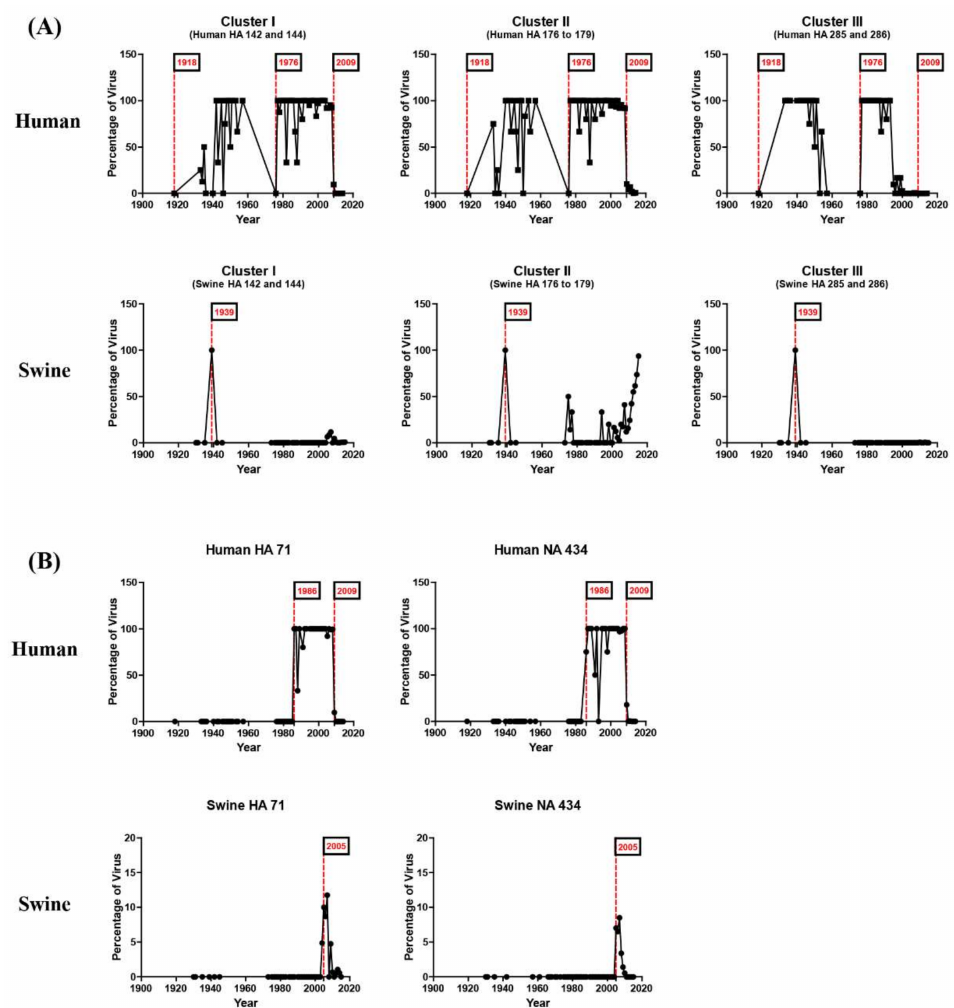
Figure 5. The reverse zoonosis of influenza predicted by glycosylation patterns of H1N1 HA and NA. The glycosylation patterns of HA and NA for human and swine species isolated between 1918 and 2015 were analyzed. A gradual increase in glycosylations in cluster II was observed in swine HA in recent years, except for the year 1939 when glycosylation occurred in all three clusters ( A ). The position 71 glycosylation in HA and the position 434 glycosylation in NA were simultaneously identified from 1986 to 2009 in human isolates ( B ). The cosegregation of the two independent mutations could be considered as a genetic characteristic of adaptation to humans. The swine isolates had a glycosylation at position 71 in HA and position 434 in NA in 2005, indicating “reverse zoonosis” from humans into